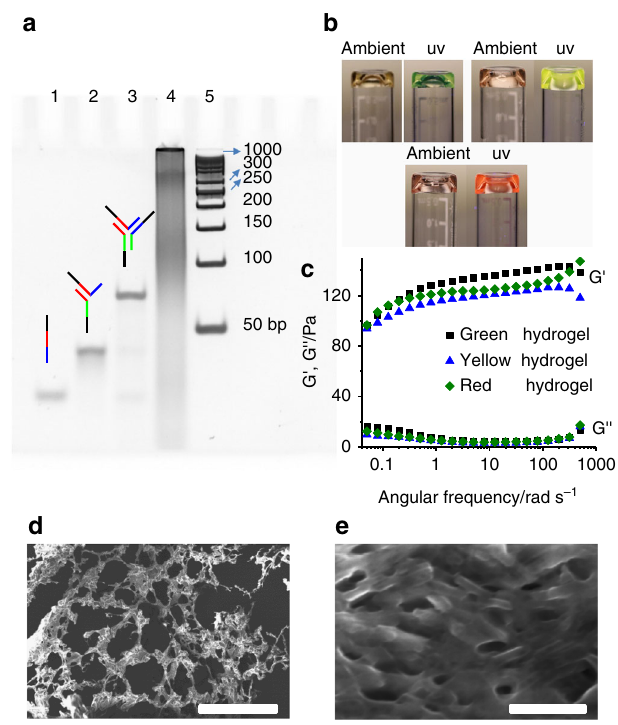
Fig. 3 Self-assembly and hydrogel formation of QDHs. a Native PAGE analysis to verify self-assembly of the QD-DNA and Y-shaped DNA nanostructures: Lane 1: Y1; lane 2: Y1 + Y2; lane 3: Y1 + Y2 + Y3; lane 4: DNA-TWJ+ QD-DNA; lane 5: DNA ladder. b Photographs of QDHs under irradiation with ambient light and ultraviolet light. c Frequency sweep test were carried out between 0.05 and 500 rad/s at a fi xed strain of 5% for the three color hydrogels. SEM images of DNA hydrogels with low resolution ( d ) scale bar: 500 μ m and high resolution ( e ) scale bar: 500